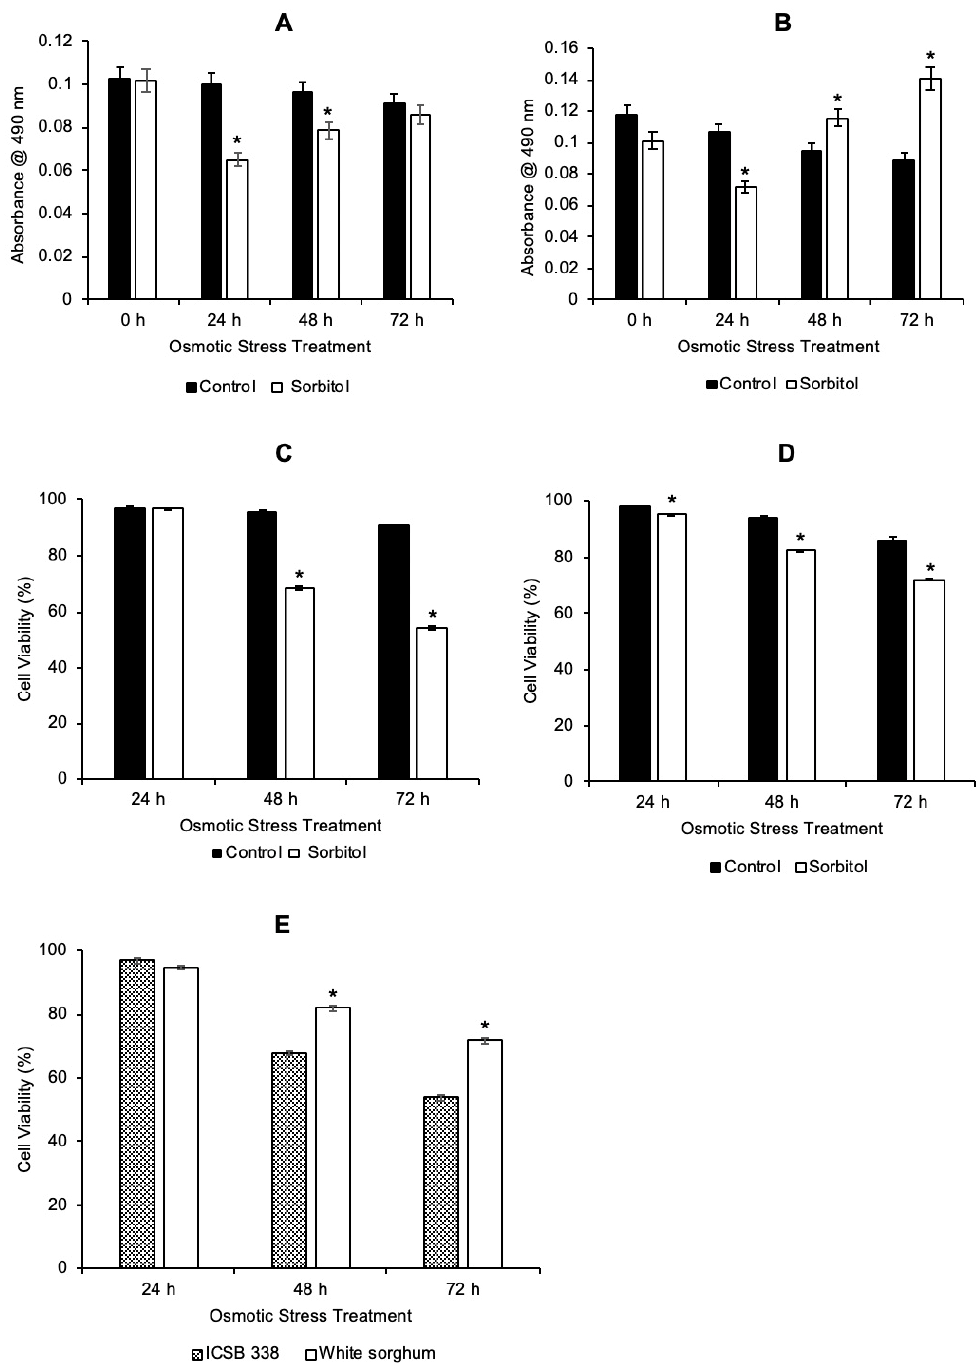
Figure 5. Cell viability of sorghum cell cultures following osmotic stress treatment using the MTT and Evans blue assays. ( A ) MTT assay results of ICSB 338. ( B ) MTT assay results of White sorghum. ( C ) Evans blue assay results of ICSB 338. ( D ) Evans blue assay results of White sorghum. ( E ) Evans blue assay results for osmotic stressed samples of both ICSB 338 and White sorghum cell cultures. Osmotic stress treatment was induced with 400 mM of sorbitol while the control was treated with distilled water for the period of 72 h. The cell viability readings at each time point is an average of two technical replicates from three independently established cell suspension cultures. Data presented as mean ± SD ( n = 3). * indicates statistically significance at a 5% level of significance according to a Student’s t ‐ test ( p < 0.05). Changes in cell structure of ICSB 338 and White sorghum cells were observed using a Nikon Eclipse E200 light microscope at a magnification of 40 (cid:3400), 72 h following stress treatment. Figure 6A,B